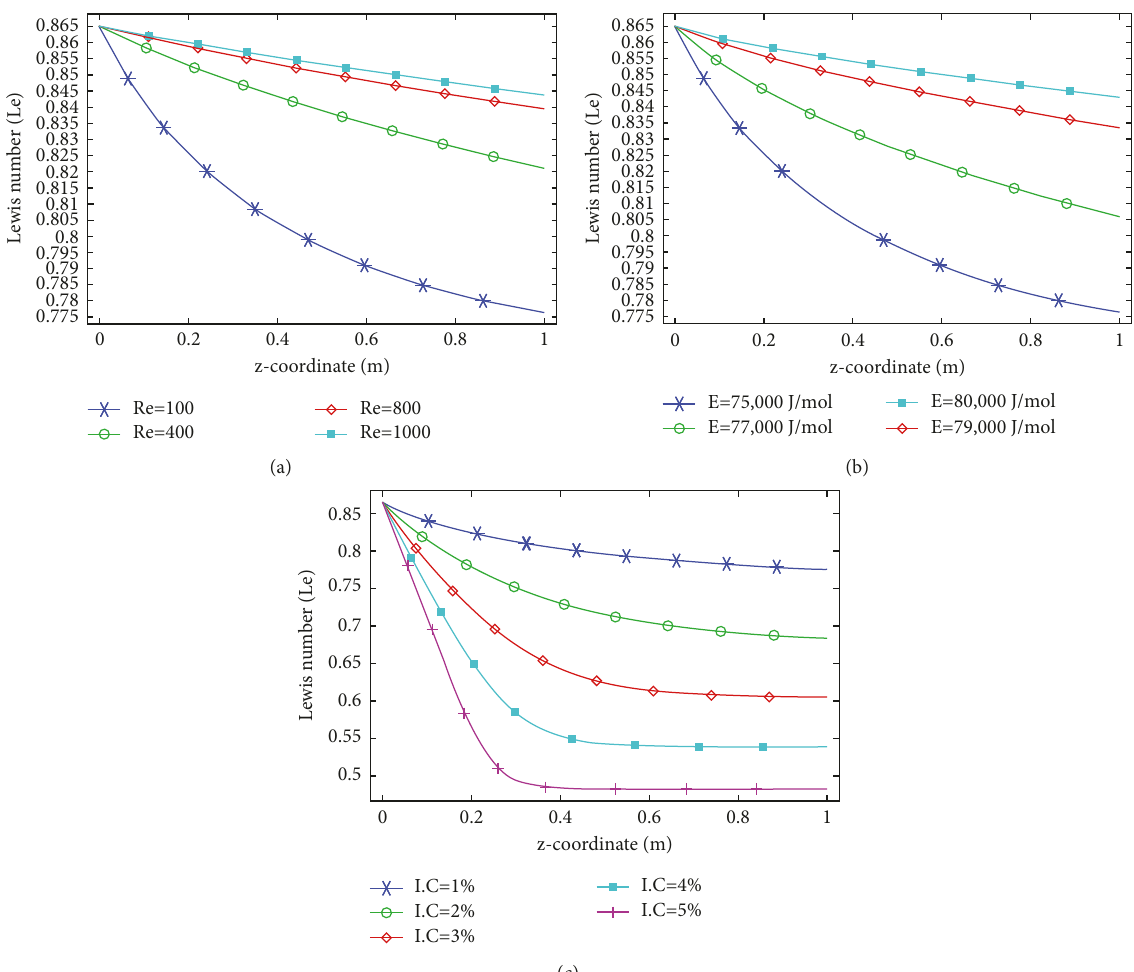
Figure 16: Lewis number along the length of the channel: (a) I.C � 1%, E � 75,000J/mol; (b) I.C � 1%, Re � 100; (c) Re � 100, E � 75,000J/